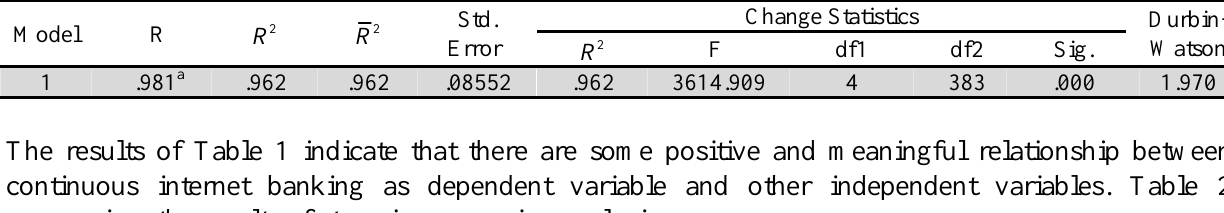
The summary of statistical observations Model